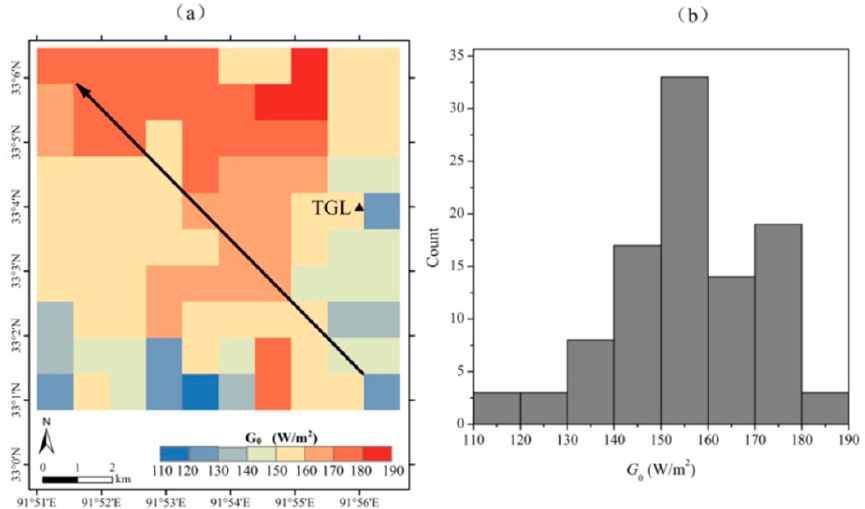
Figure 10. The spatial ( a ) and numerical ( b ) distribution of ground surface soil heat flux G 0 in the study area